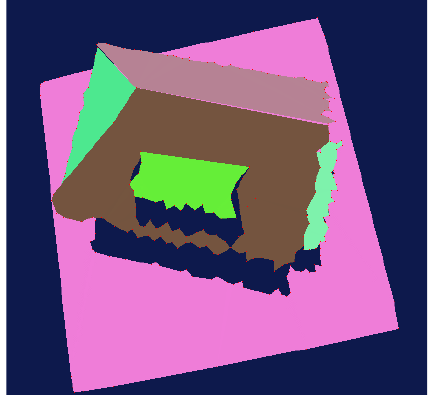
Fig. 10. Selection of roof and